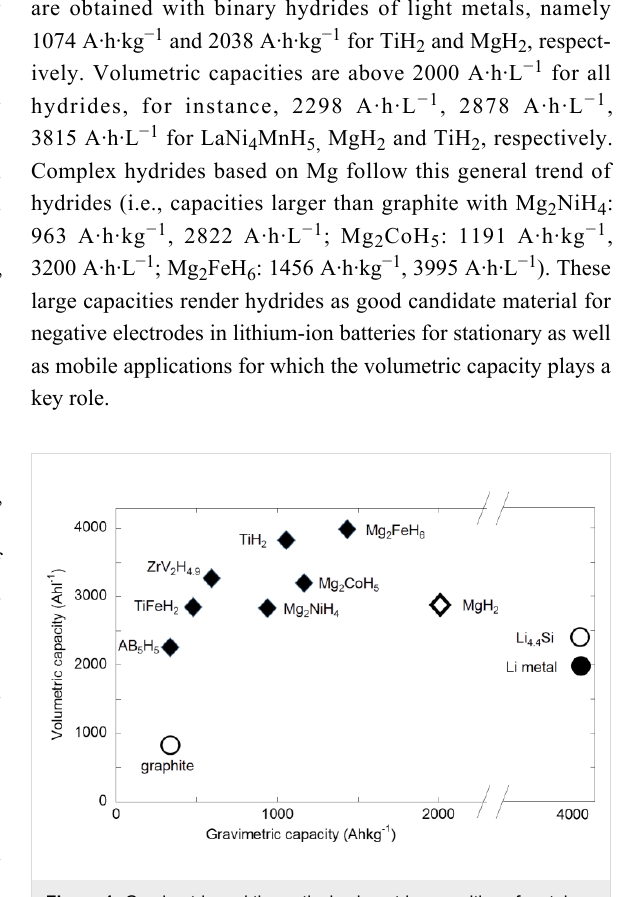
Figure 1: Gravimetric and theoretical volumetric capacities of metals and complex hydrides compared with those of graphite and other ma- terials for negative electrodes. Reproduced with permission from [13]. Copyright 2013